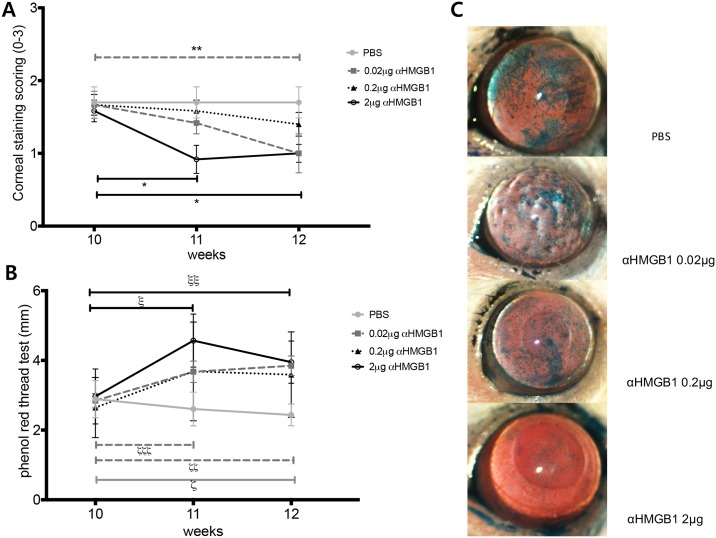
Ocular staining score and tear secretion in NOD.B10 mice after anti-HMGB1 treatment.(A) Decreased ocular staining score in 2 μg anti-HMGB1-treated mice (Wilcoxon matched-pairs signed rank test, 10 weeks vs. 11 weeks,* p = 0.0156; 10 weeks vs. 12 weeks, * p = 0.0156) and in 0.02 μg anti-HMGB1-treated mice (Wilcoxon matched-pairs signed rank test, 10 weeks vs. 12 weeks, ** p = 0.0313) compared to the baseline score. (B) Reduced tear secretion in PBS-treated control mice (Wilcoxon matched-pairs signed rank test, 10 weeks vs. 12 weeks, ςp = 0.002). Increased tear secretion in 0.02 μg anti-HMGB1-treated mice (Wilcoxon matched-pairs signed rank test, 10 weeks vs. 11 weeks, ζp = 0.0273; 10 weeks vs. 12 weeks, ζζζp = 0.0078) and in 2 μg anti-HMGB1-treated mice (Wilcoxon matched-pairs signed rank test, 10 weeks vs. 11 weeks, ξp = 0.0005; 10 weeks vs. 12 weeks, ξξp = 0.0342) compared to the pre-treatment baseline. (C) Representative images of ocular staining scoring after treatment at 12 weeks. Data are presented as mean ± standard error.